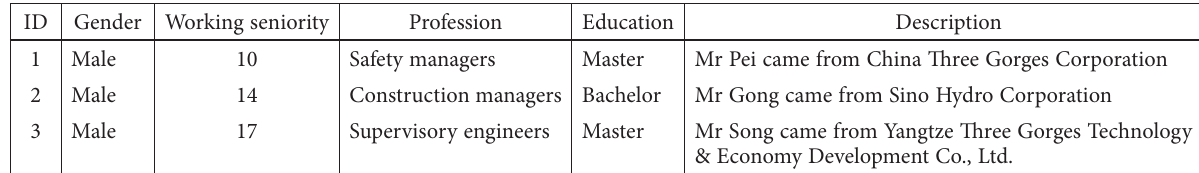
Table 2. Basic information of